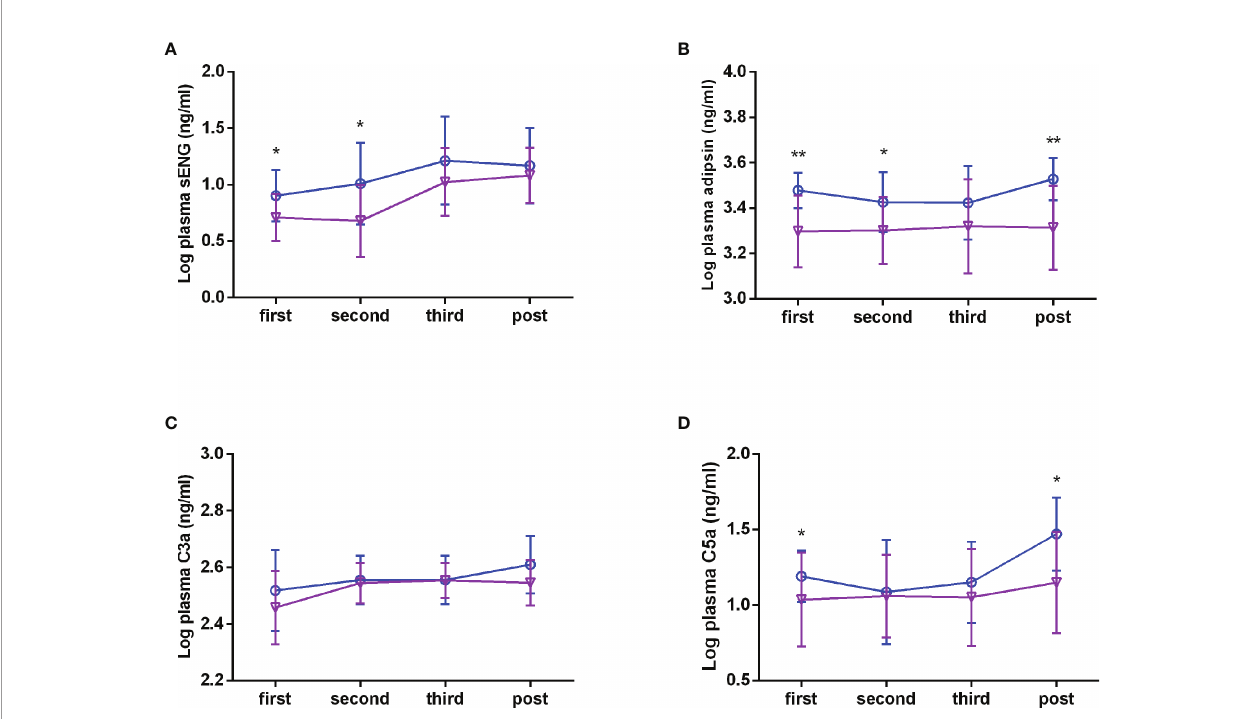
FIGURE 2 | Plasma levels of sENG, adipsin, C3a, and C5a during the pregnancy. sENG (A) , adipsin (B) , C3a (C) , and C5a (D) in the plasma samples of pregnant women with preeclampsia and healthy pregnant women throughout pregnancy were tested using ELISA kits, including in the fi rst trimester (healthy n = 35, preeclampsia n = 11); second trimester (healthy n = 31, preeclampsia n=10); third trimester (healthy n=35, preeclampsia n = 10); and the postpartum period (healthy n = 32, preeclampsia n = 10). s full line: healthy, ○ dotted line: preeclampsia. * P < 0.05, ** P < 0.01 vs . healthy pregnant